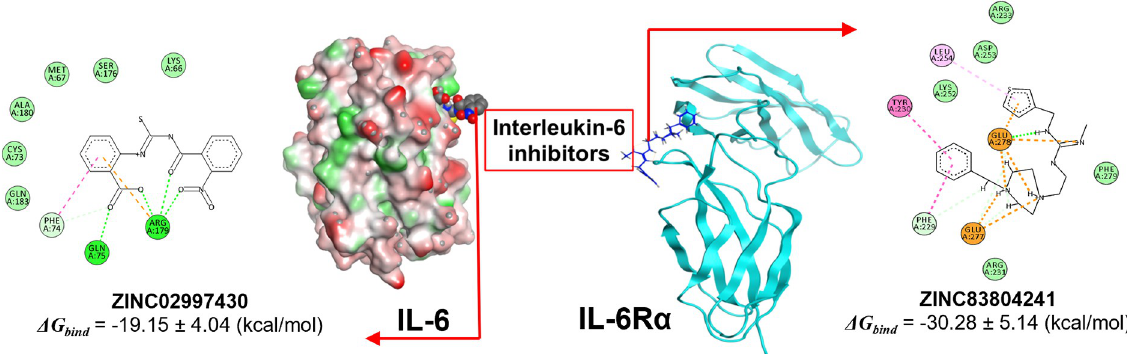
Fig 8. The interaction between ZINC02997430 and ZINC83804241 with the crucial residues at the active site of IL-6 and IL-6R α ,